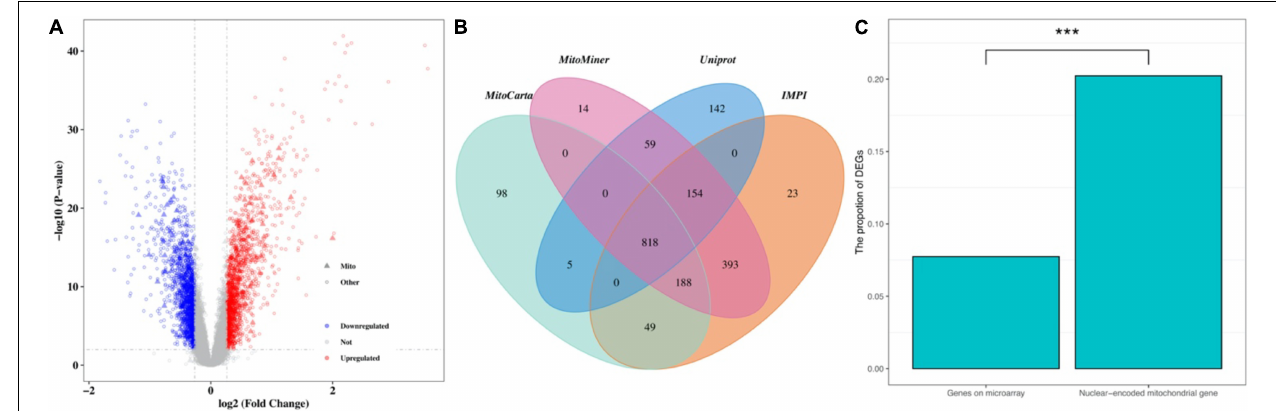
FIGURE 1 | The expression pattern of NMGenes in HCM. (A) A volcano plot shows DEGs in HCM detected from GSE36961. The vertical lines correspond to 1.2-fold up and down, respectively, and the horizontal line represents a BH-corrected p value of 0.05. Therefore, red and blue dots represent upregulated and downregulated DEGs, respectively. Triangular nodes and circle nodes represent NMGenes and the other genes, respectively. (B) A four-way Venn diagram shows the number of NMGenes collected from the MitoCarta, MitoMiner, IMPI, and UniProt databases. (C) A bar plot shows the proportion of DEGs in all genes on microarray and NMGenes. The percentage of DEGs in NMGenes was significantly larger than the percentage of DEGs in overall genes detected on microarray (Fisher’s exact test, p -value < 2.20 × 10 − 16 ). *** represents P -value <